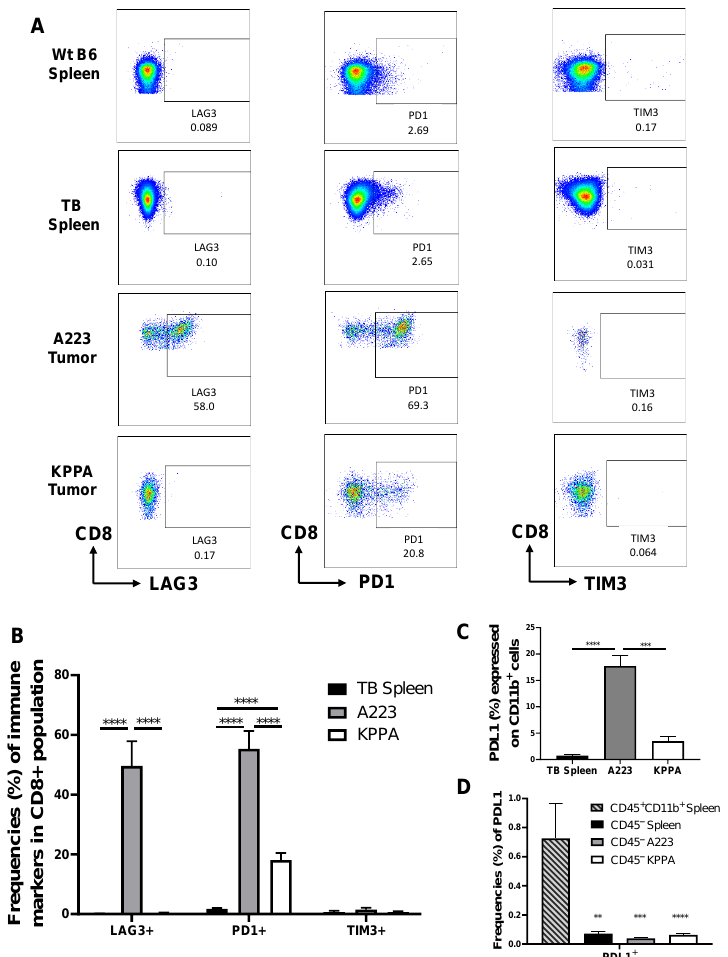
Figure 4. Expression of checkpoint molecules in CD8 T cells and programmed cell death 1-ligand 1 (PD-L1) expression in di ff erent types of cells. ( A ) Representative flow plots for lymphocyte-activation gene 3 (LAG-3), T cell immunoglobulin and mucin domain 3 (TIM-3) and PD-1 expression on CD8 T cells in WT splenic control, TB splenic control, A223 and KPPA tumors; ( B ) Quantification of the percentage of CD8 T cells expressing di ff erent markers in TB splenic control ( n = 14), A223 ( n = 11) and KPPA tumors ( n = 24); The percentage of LAG-3 + CD8 + population was significantly higher in A223 tumors (49.61 ± 8.3) than KPPA tumors (0.29 ± 0.18, p ≤ 0.0001) and TB splenic control (0.10 ± 0.04, p ≤ 0.0001); The percentage of PD1 + CD8 + population was significantly increased in KPPA tumors (18.09 ± 2.34, p = 0.0016) and A223 tumors (55.32 ± 5.98, p ≤ 0.0001) compared with the TB splenic control (2.39 ± 0.70), and was significantly higher in A223 tumors than KPPA tumors ( p ≤ 0.0001). No di ff erence was observed for TIM-3 + CD8 + population in all groups; ( C ) Quantification of the percentage of PD-L1 + CD11b + population in indicated groups. Statistically significant di ff erences were observed between A223 tumors (17.70 ± 2.03) and TB splenic control (0.72 ± 0.24, p ≤ 0.0001) or between A223 and KPPA tumors (3.49 ± 0.94, p = 0.0001); ( D ) Quantification of the percentage of PD-L1 + in indicated groups. Statistically significant di ff erences were observed between CD45 + CD11b + spleen